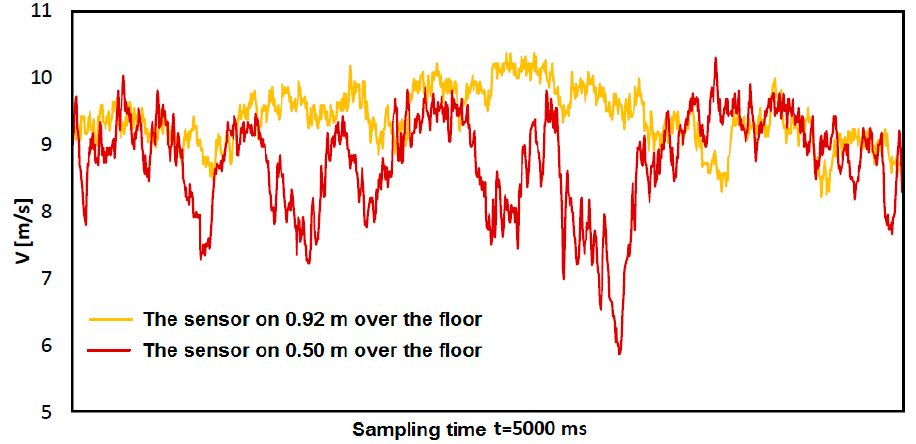
Figure 7. Wind speed measured with two anemometers placed at different heights.